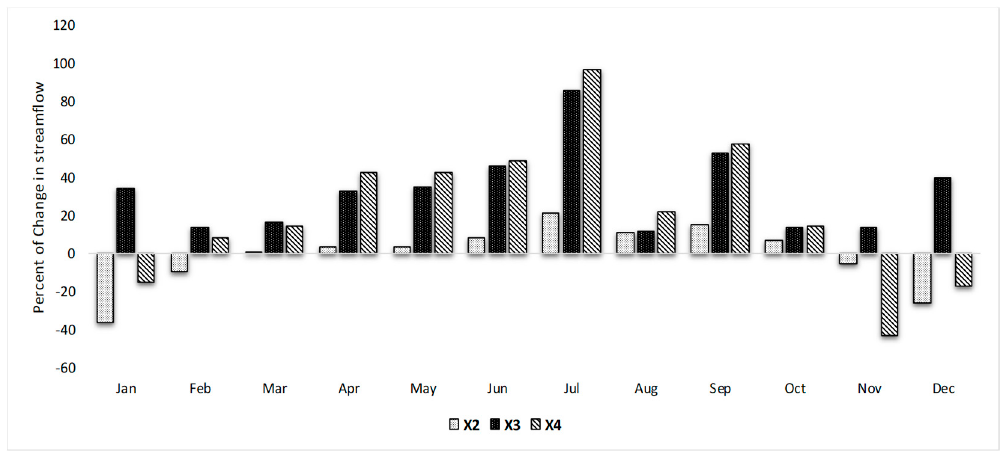
Figure 15. Absolute change in mean monthly streamflow for the UWBDR watershed under different scenarios.